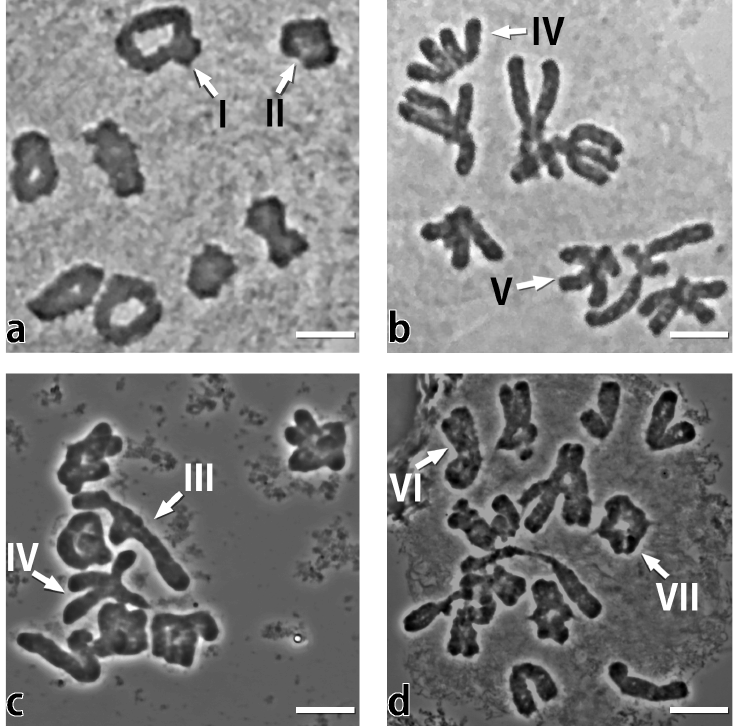
Figure 2. Acetocarmine-stained squash preparations of PMCs at metaphase I: ( a )— A. cepa , ( b )— A. fistulosum , ( c )—F 1 ( A. cepa × A. fistulosum ) diploid hybrid (2 n = 2 x = 8F + 8C), ( d )—F 1 ( A. cepa × A. fistulosum ) triploid hybrid (2 n = 2 x = 16F + 8C). Roman numbers mark different types of bivalents: I—ring bivalent with two distal and single interstitial chiasmata, II—ring bivalent with two distal chiasmata, III—heteromorphic open bivalent with interstitial chiasma, IV—univalent, V—cross-bivalent, VI—H-form of cross-bivalent, VII—ring bivalent with two interstitial chiasmata. Bars represent 10 µ